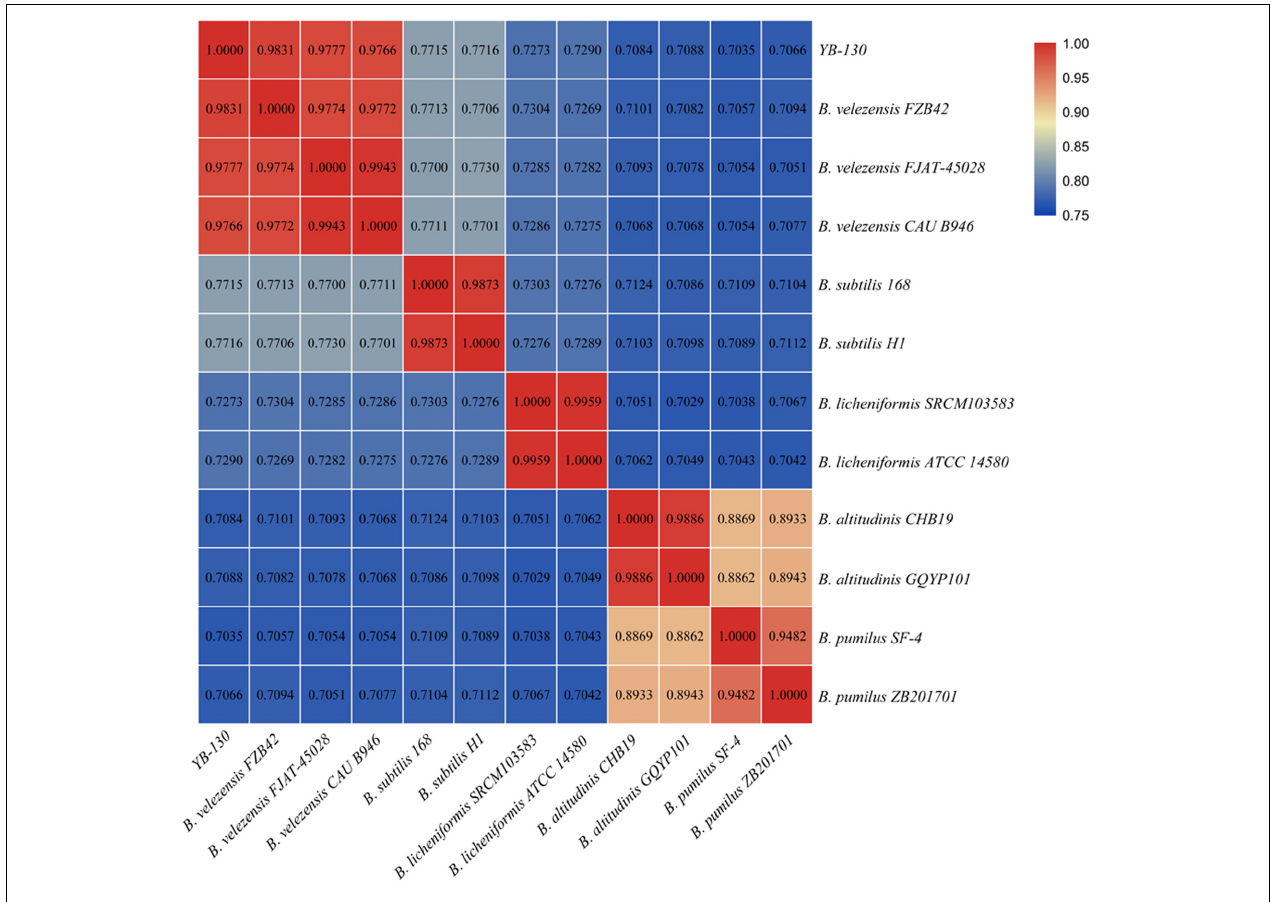
FIGURE 6 | Heatmap of pairwise average nucleotide identity (ANI) values for whole genomes of strain YB-130 and 11 other Bacillus species.